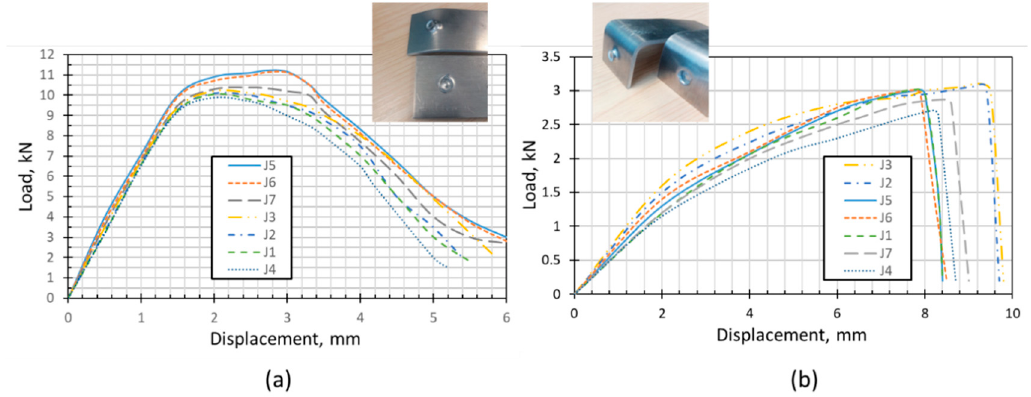
Figure 6. Representative experimental force–displacement curves for ( a ) the shear, and ( b ) peel tests of different joints.